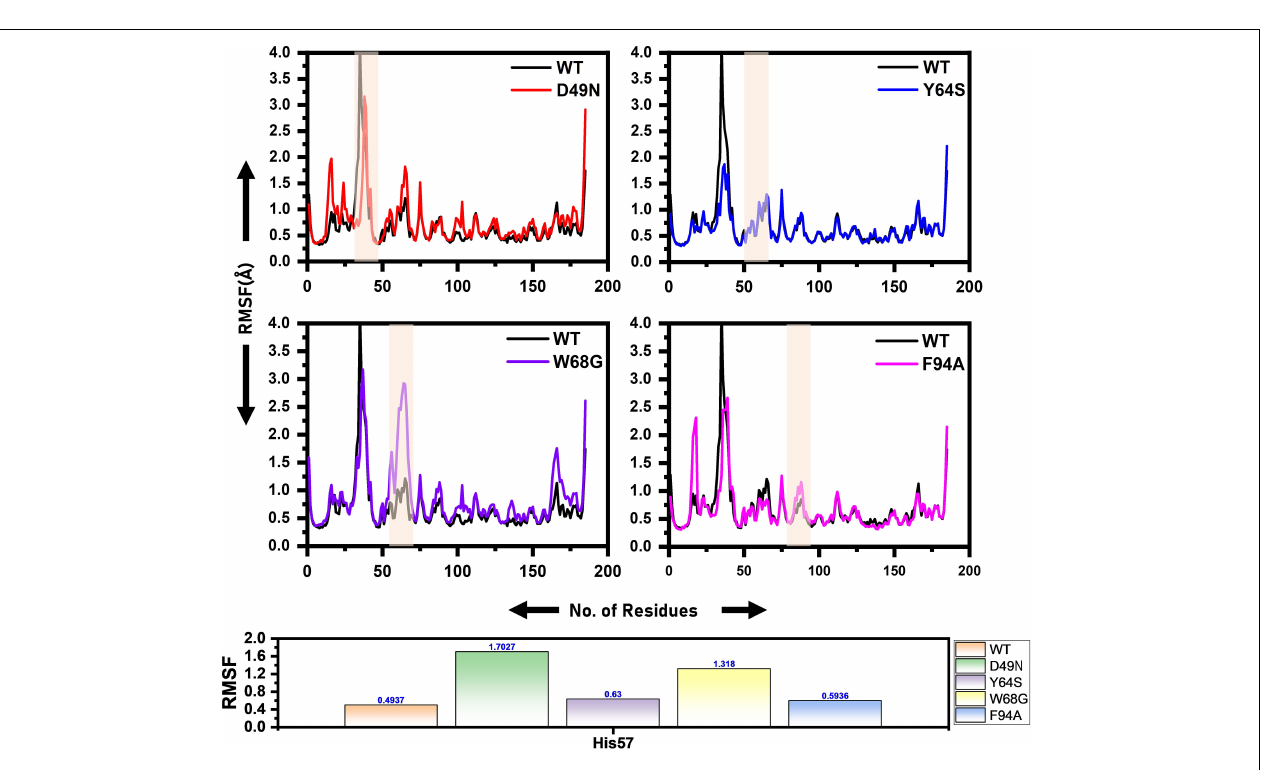
distance between the wild type and the PZA is conserved, and the average distance reported was 8Å. However, this distance significantly fluctuates in the case of D49N, W68G, and F94A.